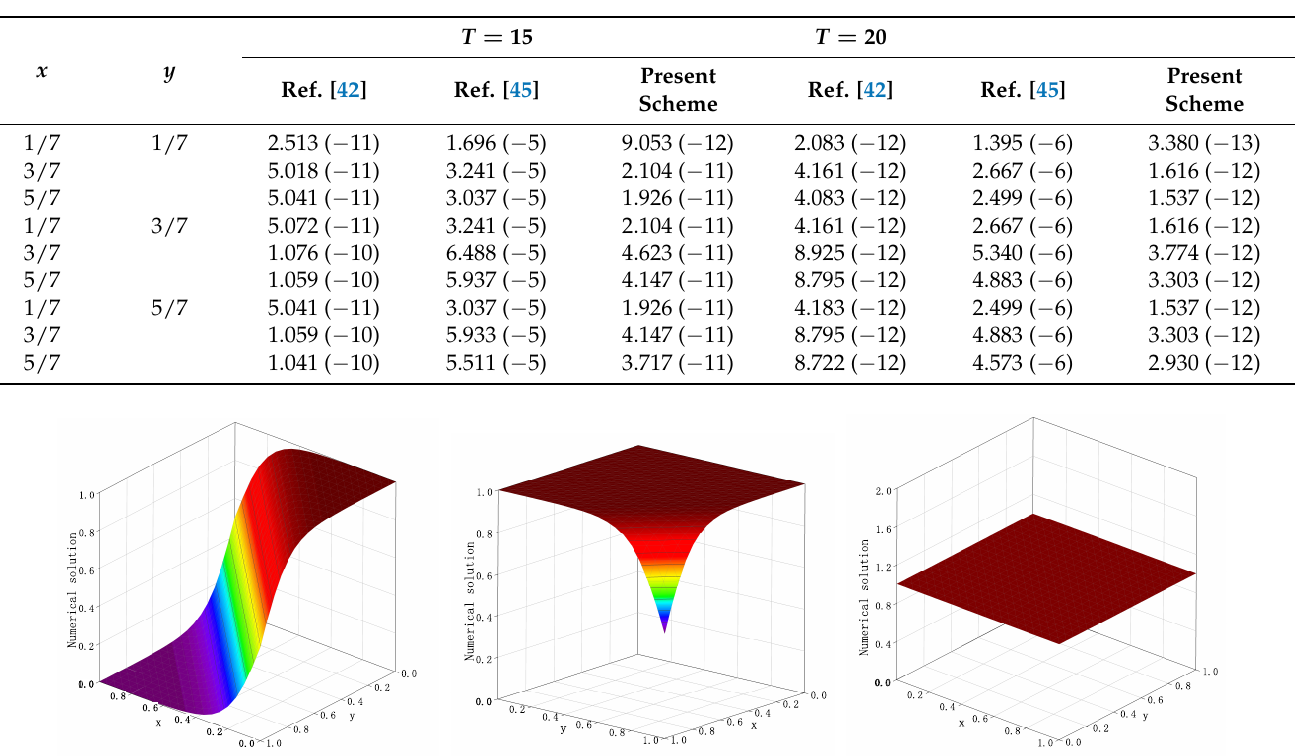
Table 2. The absolute error when N = 7, τ = 0.01, α = 1 for Problem 1.